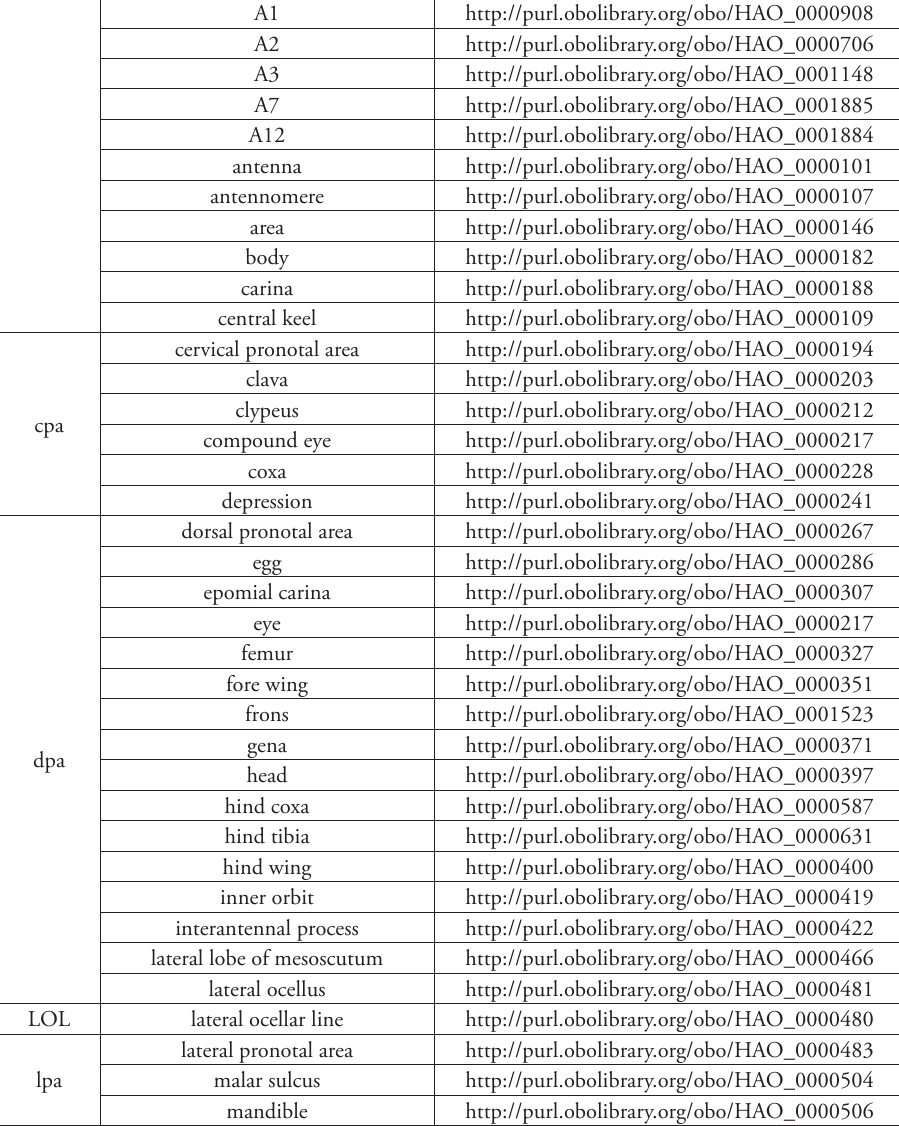
URI Table matching terms and concepts used in this revision with the Hymenoptera Anatomy Ontology